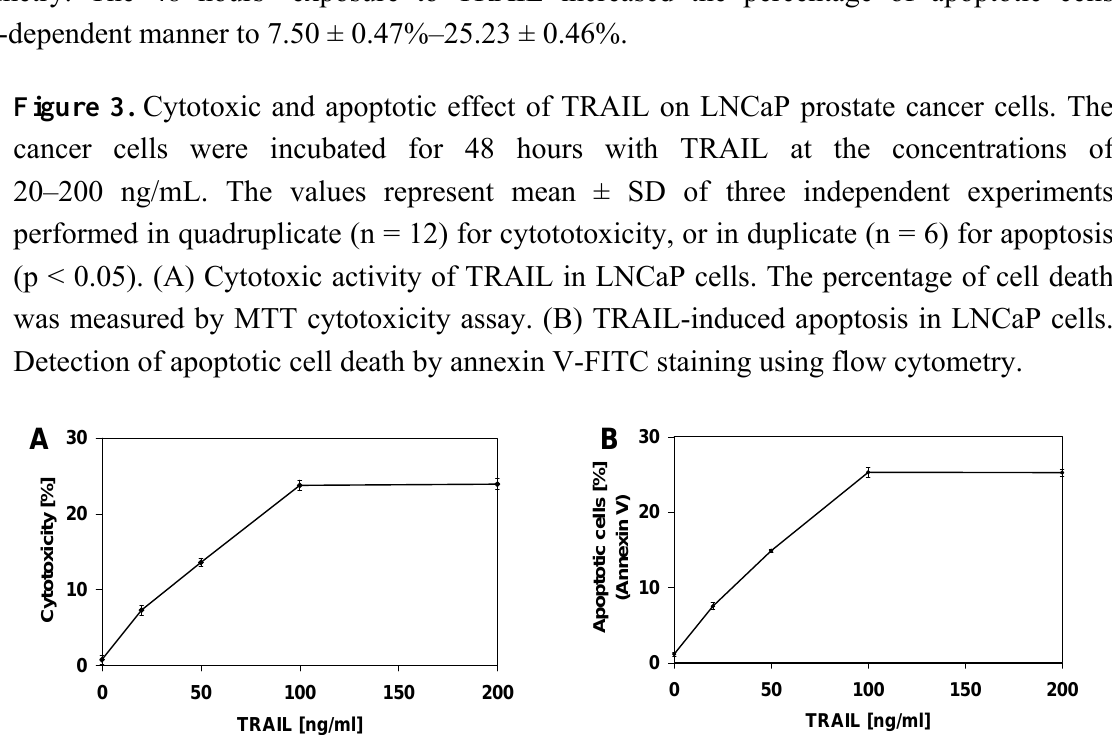
Figure 4. Chalcones in combination with TRAIL increased the percentage of cell death (22.98 ± 0.84%–80.06 ± 0.87% for chalcone, 25.36 ± 0.98%–89.32 ± 0.47% for licochalcone-A, 24.47 ± 0.84%–85.90 ± 0.91% for isobavachalcone, 26.22 ± 1.22%–93.20 ± 0.60% for xanthohumol and 36.82 ± 0.87%–81.97 ± 0.84% for butein) compared to cytotoxicity of TRAIL and chalcones